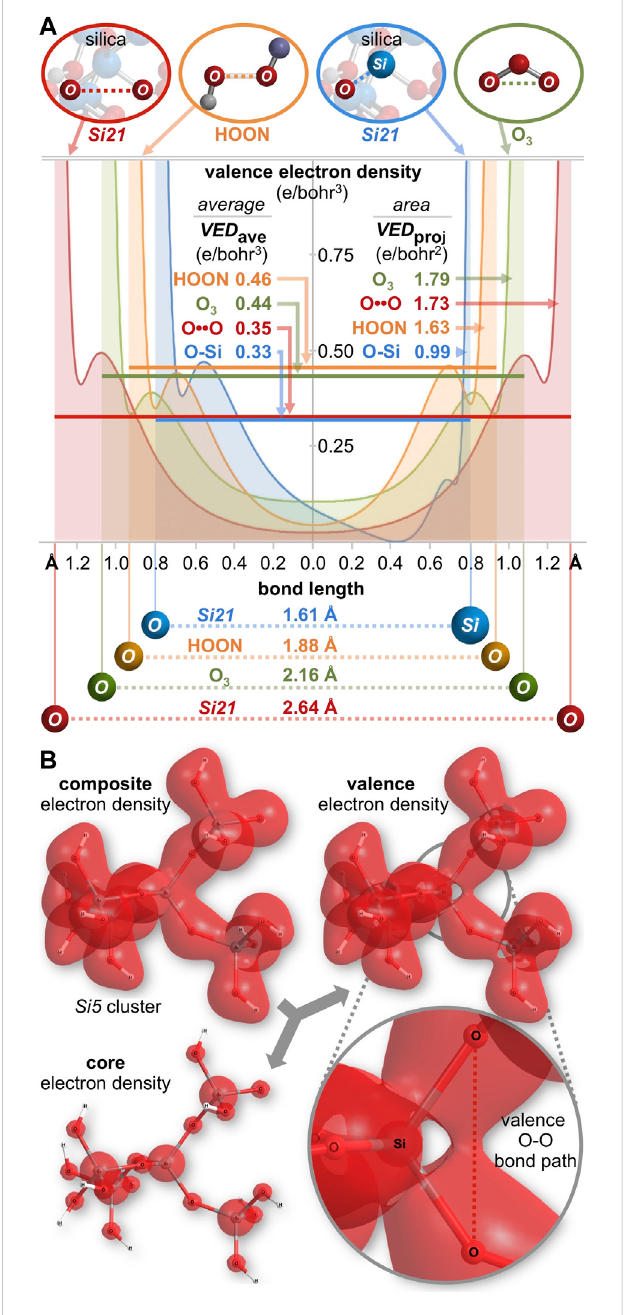
FIGURE 9 (A) Valence electron density along the O-O (or Si-O) bond axis for silica ( Si21 cluster), HOON, and ozone (O 3 ). The average internuclear valence electron density is VED average , with units of e/bohr 3 . A superior metric for valence electron accumulation along the bond axis is the area under the curves, VED projection , with units of e/bohr 2 . For silica, VED projection is greater for O-O (1.73 e/bohr 2 ) than for O-Si (0.99 e/bohr 2 ). (B) A three-dimensional valence electron density surface (IsoValue = 0.022 e/bohr 3 ) for the Si5 cluster (Si 5 O 16 H 12 ) reveals an oxygen-oxygen valence bond path ( VED min = 0.025 e/bohr 3 ), but no such path for silicon-oxygen ( VED min = 0.000 e/bohr 3